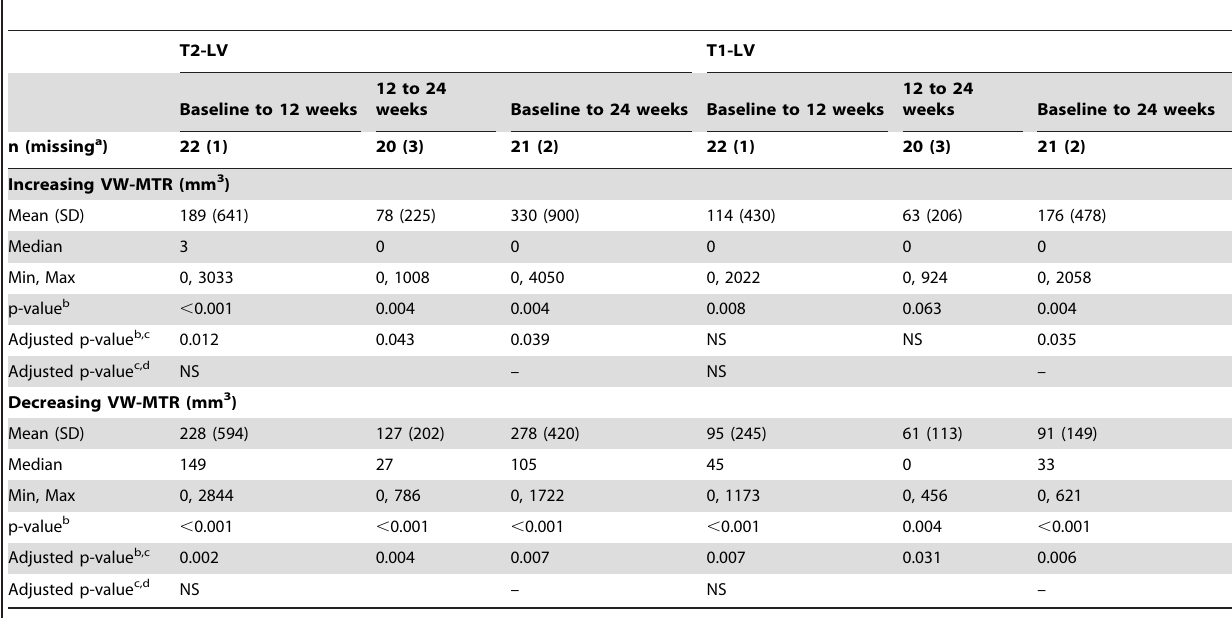
Table 4. Change in T2-LV and T1-LV over time in patients with increasing and decreasing VW-MTR (mm 3 ).